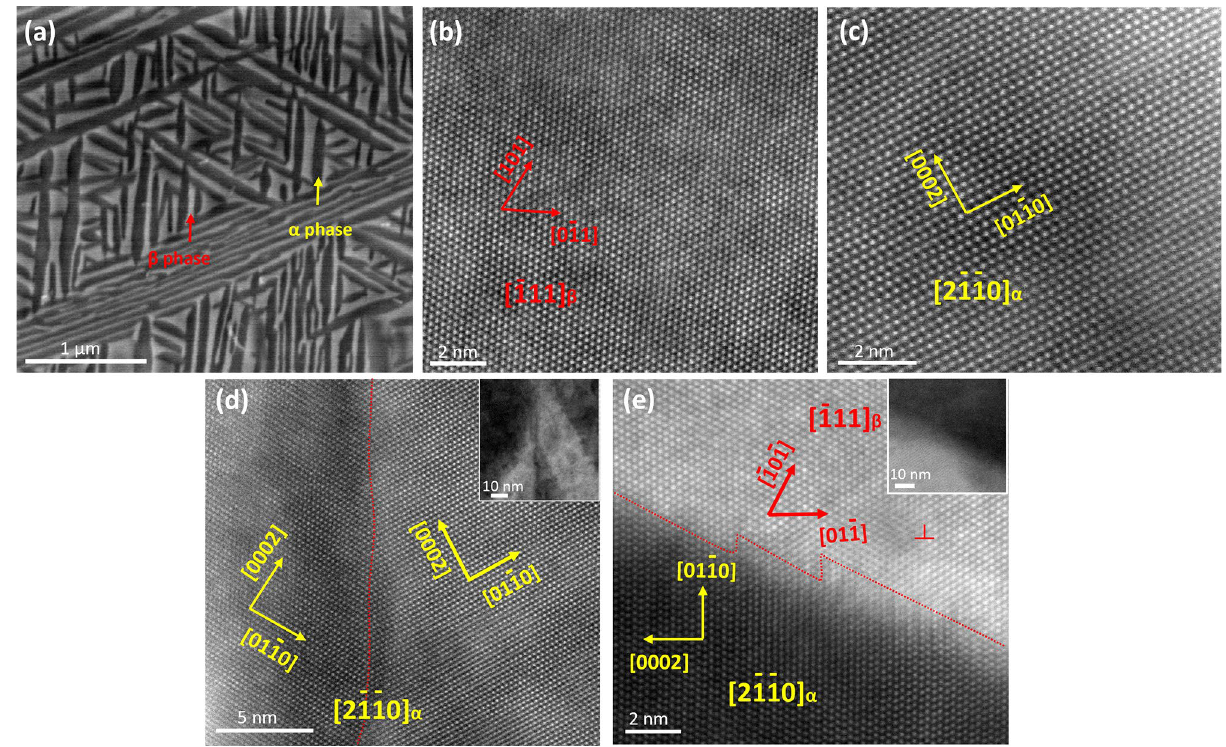
Figure 1. Microstructure of the dual-phase TiMo alloy. ( a ) Scanning electron microscopy image showing the homogeneous distribution of α and β phases. ( b , c ) HAADF images showing the atomic structure of β phase and α phase, viewed along [ 111 ] β and [ 2110 ] α , respectively. ( d ) Atomic resolution HAADF image showing the α–α interface viewed along [ 2110 ] orientation. ( e ) Atomic resolution HAADF image showing the α–β interface viewed along [ 2110 ] α // [ 111 ] β